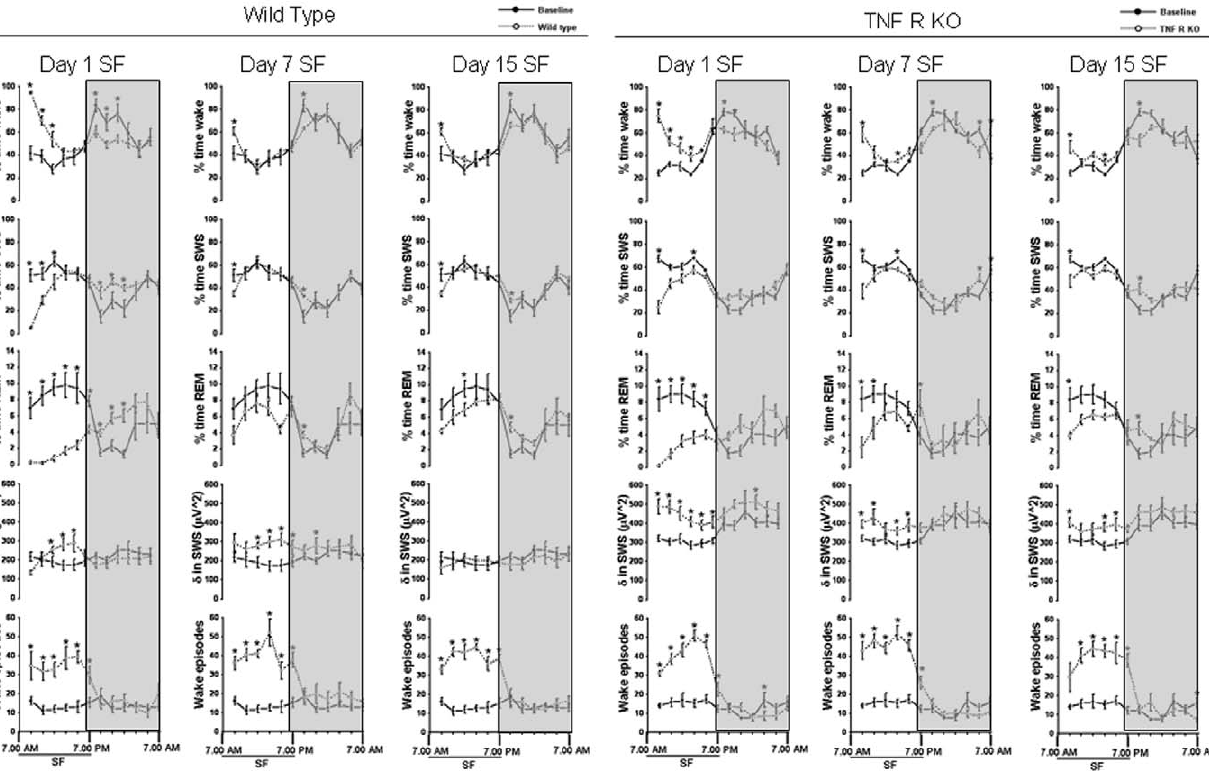
Figure 1. Sleep-wakefulness, EEG delta power in SWS and wake episodes (2 hr bins) in wild type and TNF R KO mice. Comparison of sleep parameters in WT and TNFR KO mice at baseline (solid line represents baseline values in the respective group), day 1, day 7 and day 15 of SF (dashed line represents SF values in the respective group). Shaded area represent dark period. The black line indicates SF period (7.00 am to 7.00 pm). SF, sleep fragmentation. p , 0.05. *=comparison between baseline and SF during respective post-fragmented days.